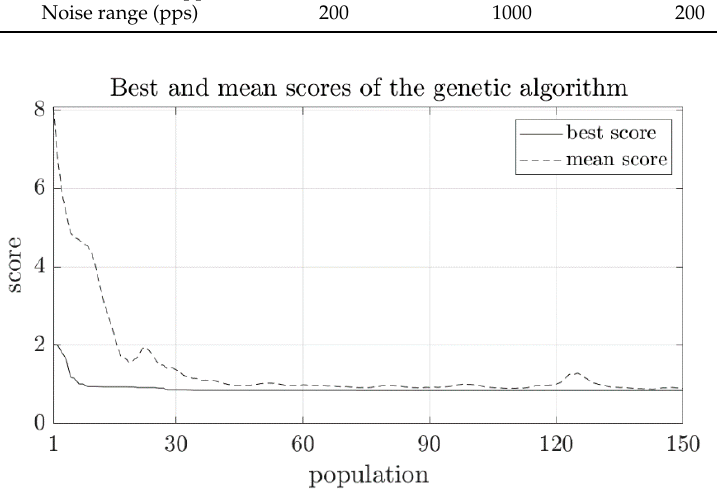
Figure 6. The convergence curve of the genetic algorithm. Minimized function, so the score, is dimensionless.